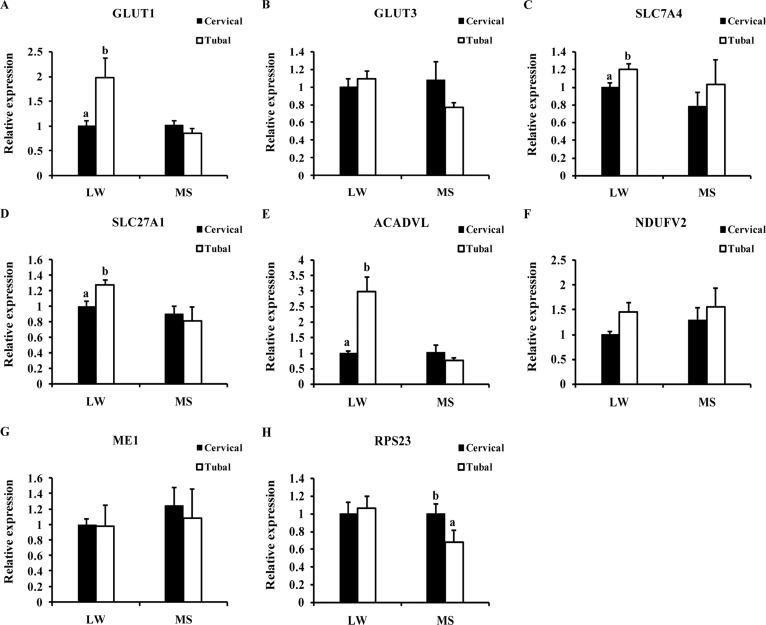
RT-PCR validation of eight proteins of differential abundance from the placenta from different uterine position at the mRNA level.Cervical: the fetuses at the position toward the cervix; Tubal: the fetuses at the position toward the utero-tubal junction; LW: Large White gilts; MS: Meishan gilts. GLUT1: Glucose transporter 1; GLUT3: Glucose transporter 3; SLC7A4: Cationic amino acid transporter 4; SLC27A1: Solute carrier family 27; ACADVL: Long-chain acyl-CoA synthetase ACSL; NDUFV2: NADH dehydrogenase [ubiquinone] flavoprotein 2; ME1: NADP-dependent malic enzyme; RPS23: 40S ribosomal protein S23.